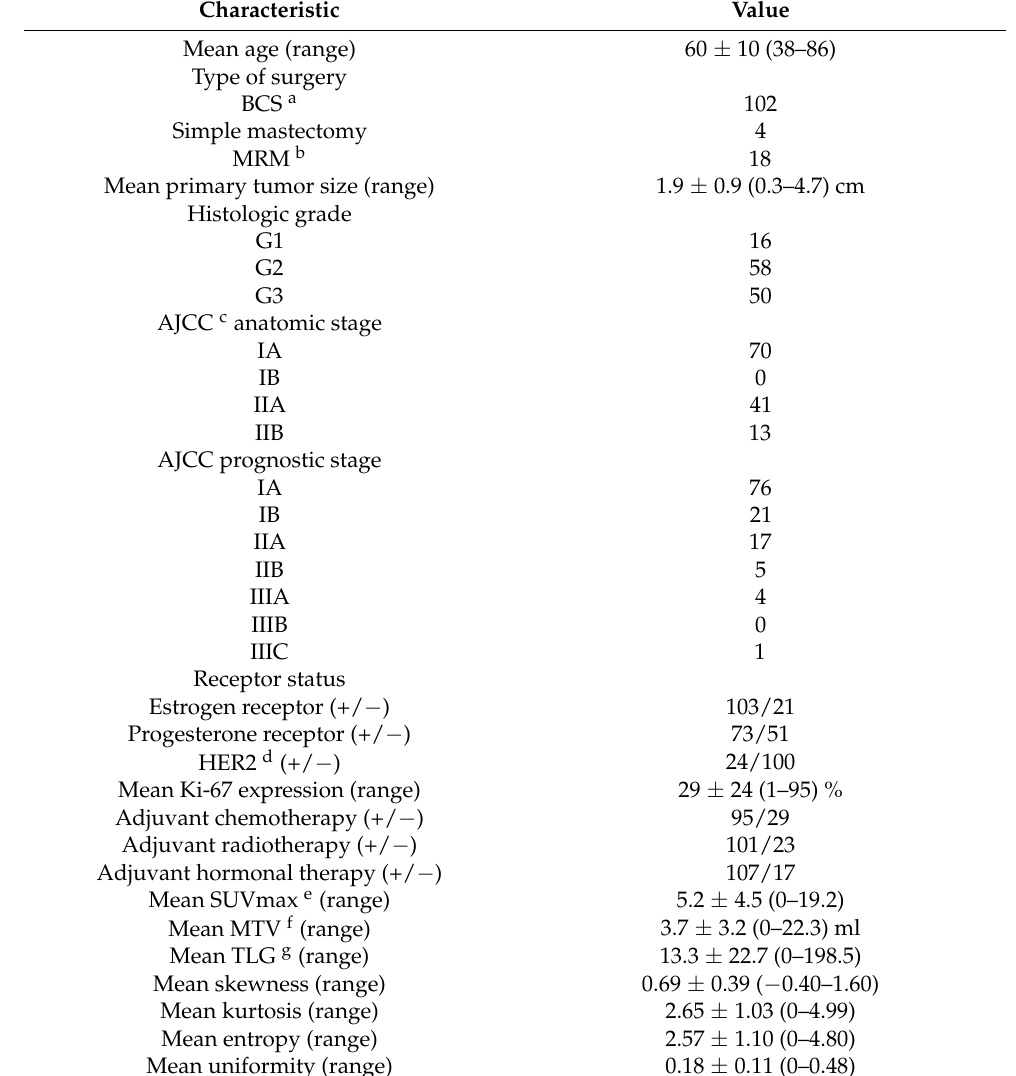
Table 1. Clinical and pathological characteristics of patients.